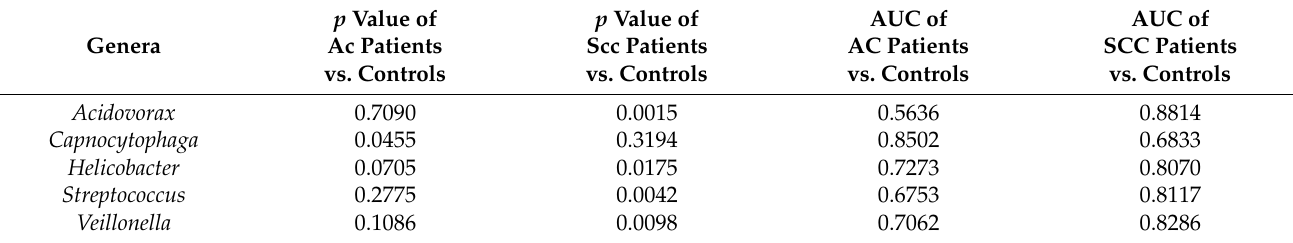
Table 4. The five bacterial genera display different levels in sputum samples of NSCLC patients vs. cancer-free controls of cohort 1.